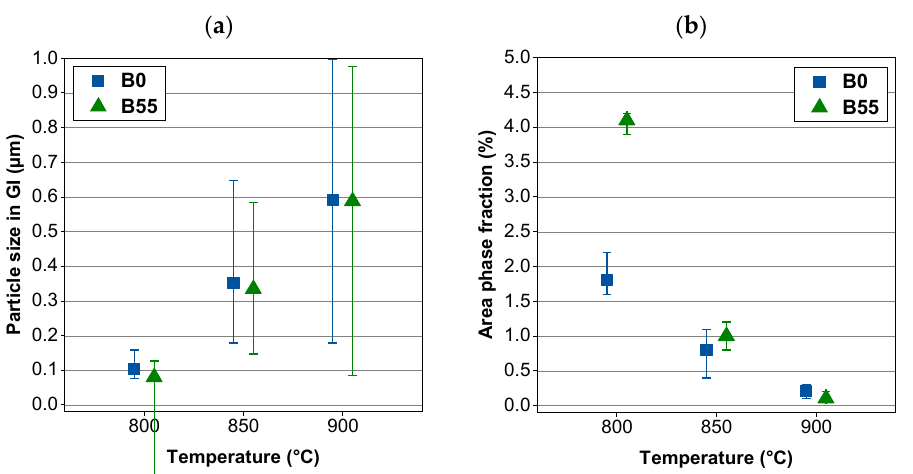
Figure 4. Quantitative particle analysis results: ( a ) mean particle size in the grain interior (GI) and ( b ) area phase fraction after thermomechanical treatment of the reference B0 and the boron-alloyed B55 steel with varying deformation temperature (800/850/900 °C; deformation grade, 0.5).